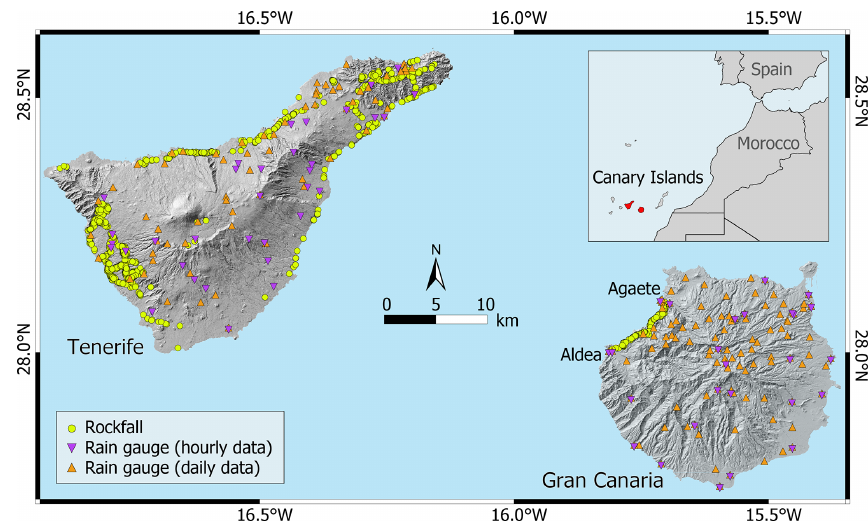
Figure 1. GC and TEN test sites. Location of the rain gauges providing hourly (purple triangles) and daily (orange triangles) rainfall measurements and of rockfalls used for threshold calculations (light green dots). Hillshade derived from MDT05 2009 CC-BY 4.0